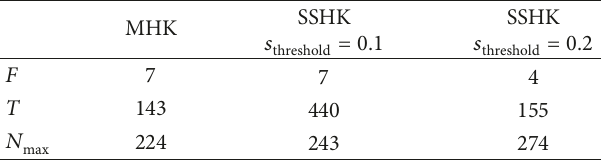
Table 1: Comparison of stable time ( 𝑇 ), opinion cluster number ( 𝐹 ), and the relative size of the largest cluster 𝑁 and SSHK model ( 𝑤 𝑠 = 0.3 ) when 𝜀 = 0.05 .